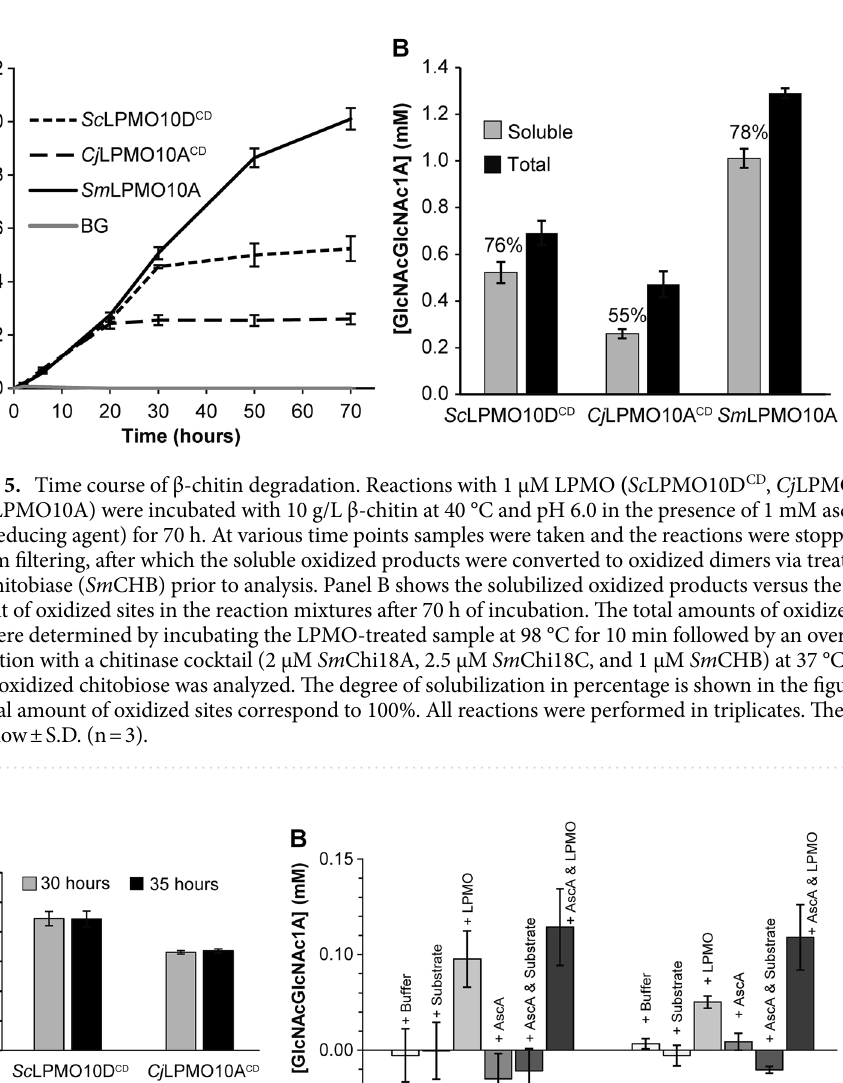
binding studies of the three LPMOs with β-chitin (Supplementary Fig. S5) showed that Sc LPMO10D CD binds with weak affinity to β-chitin, similar to Cj LPMO10A CD , which may explain the lower stability visible in Fig. 5. Only Sm LPMO10A displayed a clear binding curve over time and this enzyme showed superior performance in the experiments depicted in Fig. 5. To assess whether stability differences (Fig. 5A) could also relate to differences in folding stability, the appar- ent melting temperature (T m ) of Sc LPMO10D CD was determined by monitoring the effect of temperature on binding of a fluorescent dye (SYPRO orange). The obtained melting curve (see Supplementary Fig. S6) shows that copper-loaded Sc LPMO10D CD has an apparent T m of 63 °C which is lower compared to the previously determined apparent melting temperatures of 71.2 °C for Sm LPMO10A 47 and 70.2 °C for Cj LPMO10A CD51 , but